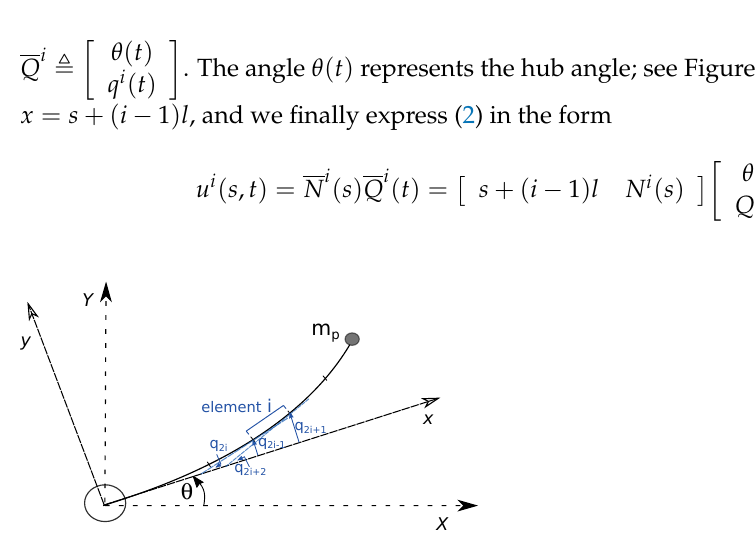
Figure 3. One element of arm with state-coordinates in